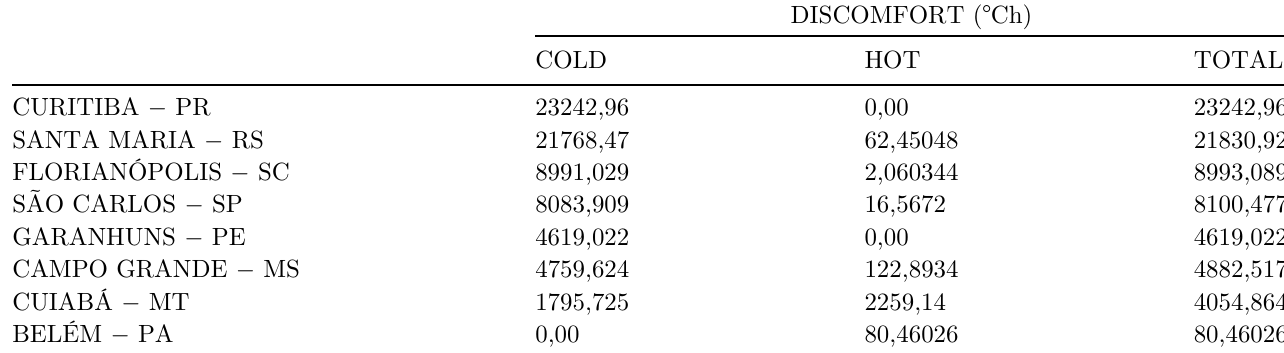
Table 3. Discomfort ( ° Ch) obtained for the simulations of the reference model.